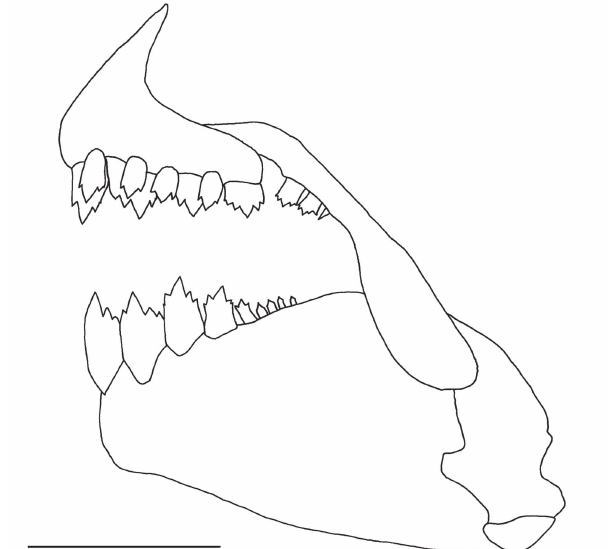
Fig. 3. Jaws of Hasemania uberaba , left side, paratype, DZSJRP 8730, 36.8 mm SL. Scale bar = 1.5 mm.